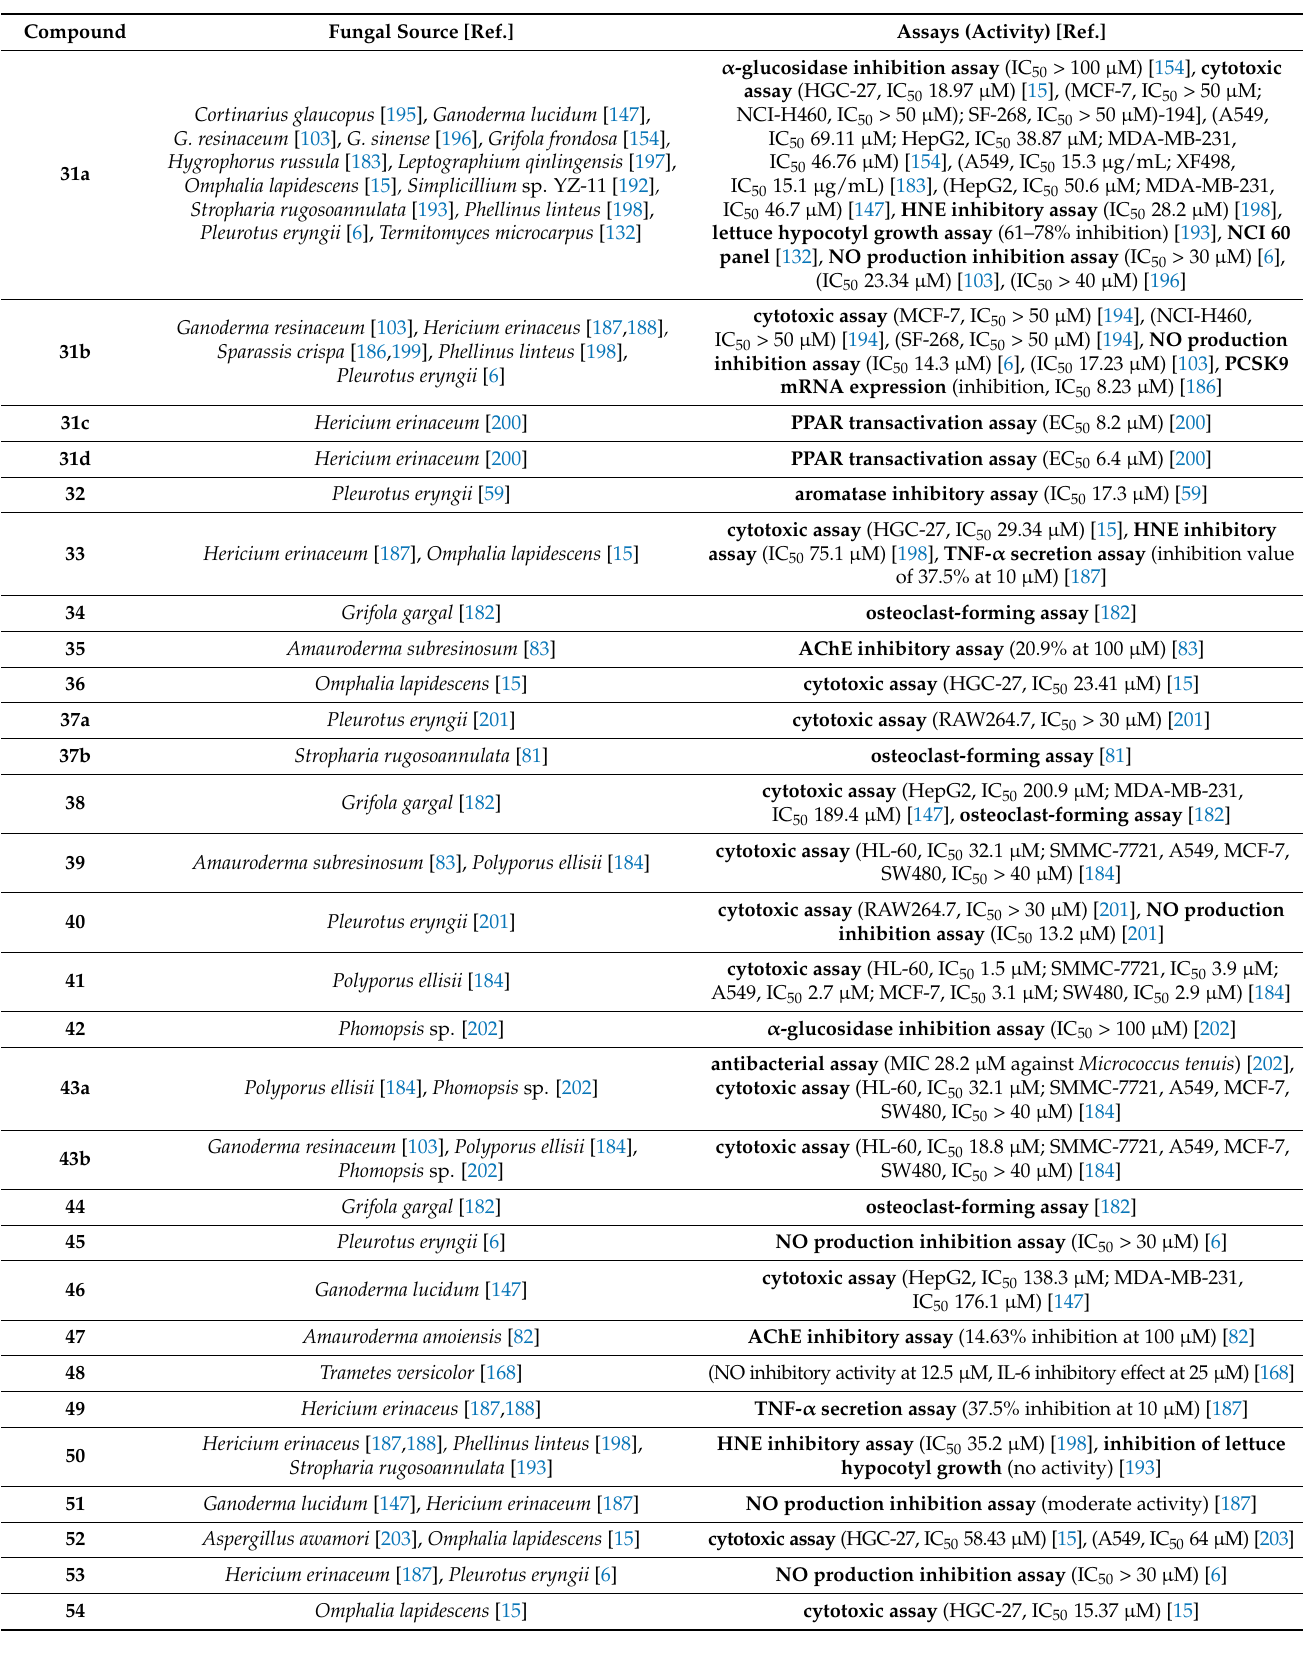
Compound Fungal Source